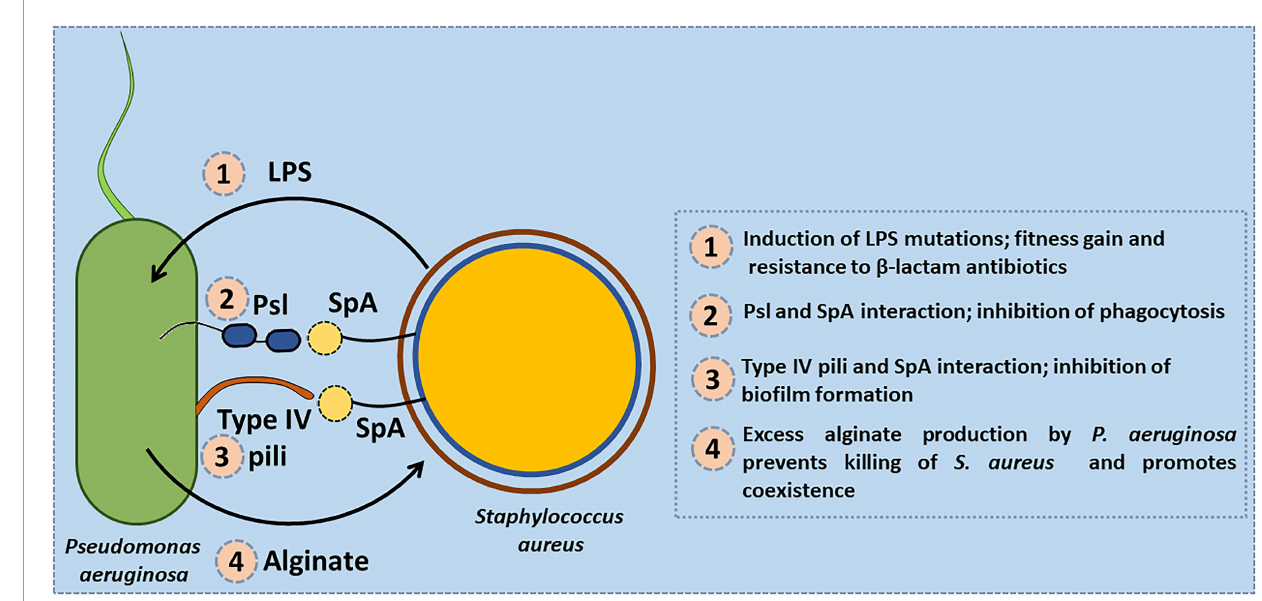
FIGURE 5 | Co-operative interactions between S. aureus and P. aeruginosa. (1) S. aureus induces mutations in the genes encoding the lipopolysaccharide (LPS) biosynthesis in P. aeruginosa that confers fi tness gain and enhanced resistance to b -lactam antibiotics. (2) Protein A (SpA) produced by S. aureus interacts with the Psl ( Pseudomonas polysaccharide locus) polysaccharide of P. aeruginosa and protects it from being phagocytosed by neutrophils. (3) SpA interacts with type IV pili of P. aeruginosa and inhibits bio fi lm formation by P. aeruginosa strains. (4) Exogenous alginate secreted by P. aeruginosa protects S. aureus by reducing the production of virulence factors such as siderophores, and